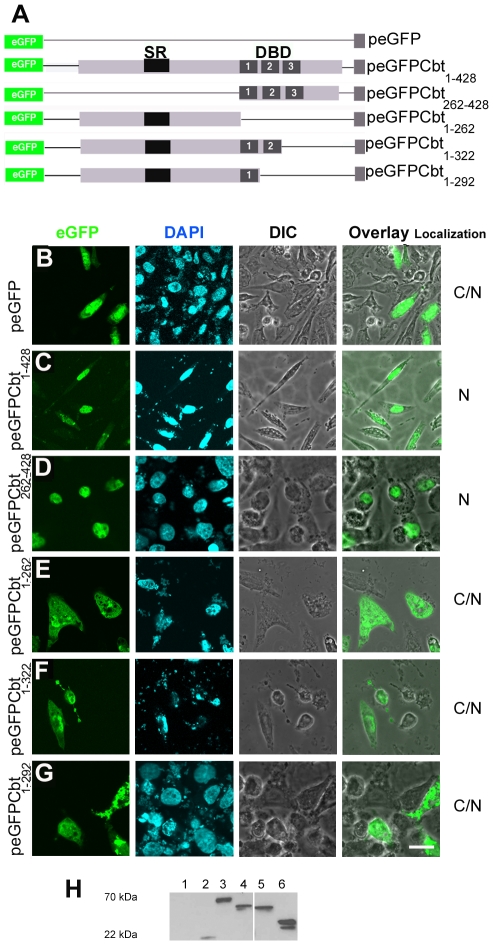
The Cabut zinc finger region is not essential for nuclear localization in CHO-K1 cells.(A) Schematic representation of the eGFPCbt fusion constructs used to transfect CHO-K1 cells. The locations of the SR region (black rectangle) and the zinc fingers (1, 2, 3, grey rectangles) are indicated. (B–G) Localization of eGFP fusion proteins in CHO-K1 cells transiently transfected with the constructs shown in (A). Cells were immunostained with anti-eGFP (green, first panel) and DAPI (blue; second panel). Differential interference contrast (DIC) was used to visualize cell boundaries (third panel). The overlay panel shows DIC and anti-eGFP staining. The localization of the fusion proteins is shown in the fourth panel (C, cytoplasmic; N, nuclear). Wild-type eGFP was located in the cytoplasm and the nucleus (B), but the eGFPCbt fusion protein translocates to the nucleus (C). With the exception of the peGFPCbt262–428 fusion protein, which lacks the N-terminal region of the Cbt protein (G), all Cbt deletions affecting the zinc finger region showed cytoplasmic localization (D–F). Scale bar: 10 µm. (H) Western blots of protein extracts from CHO-K1 cells transfected with the constructs shown in (A) and stained with anti-GFP. (1) Non-transfected cells, (2) empty peGFP vector (∼27 kDa), (3) peGFPCbt1–428 (∼70 kDa), (4) peGFPCbt1–322 (∼60 kDa), (5) peGFPCbt1–292 (∼60 kDa) and (6) peGFPCbt1–262 (∼50 kDa).